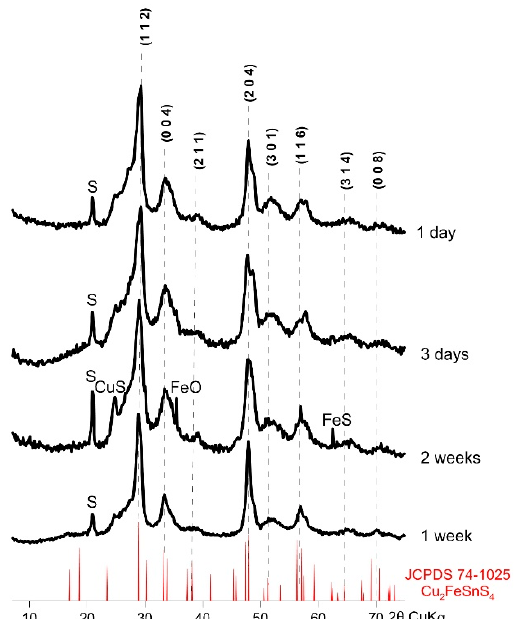
Figure 4. Powder X-ray diffraction patterns of synthetic Cu 2 FeSnS 4 (CFTS) resulting from different synthesis times (synthesis at 195 °C and EG:H 2 O = 7:1). All experiments resulted in a tetragonal stannite identical to JCPDS standard No 74-1025. The optimal reaction time is one week.